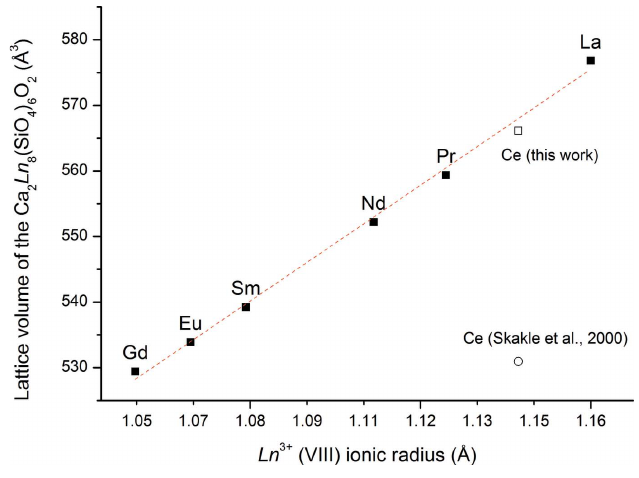
Figure 2 Plot of the volume of Ca 2 Ln III 8 (SiO 4 ) 6 O 2 Ln -apatites versus ionic radii of Ln 3+ ions in a VIII-coordinated